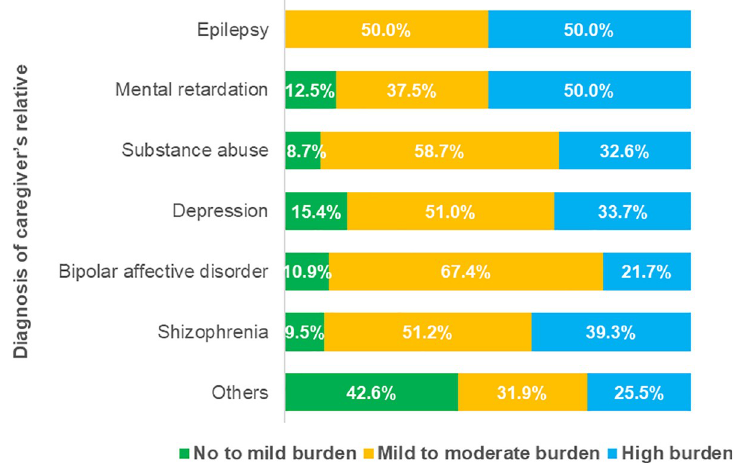
Fig 1. Prevalence of caregiver burden of care according to caregiver’s patient